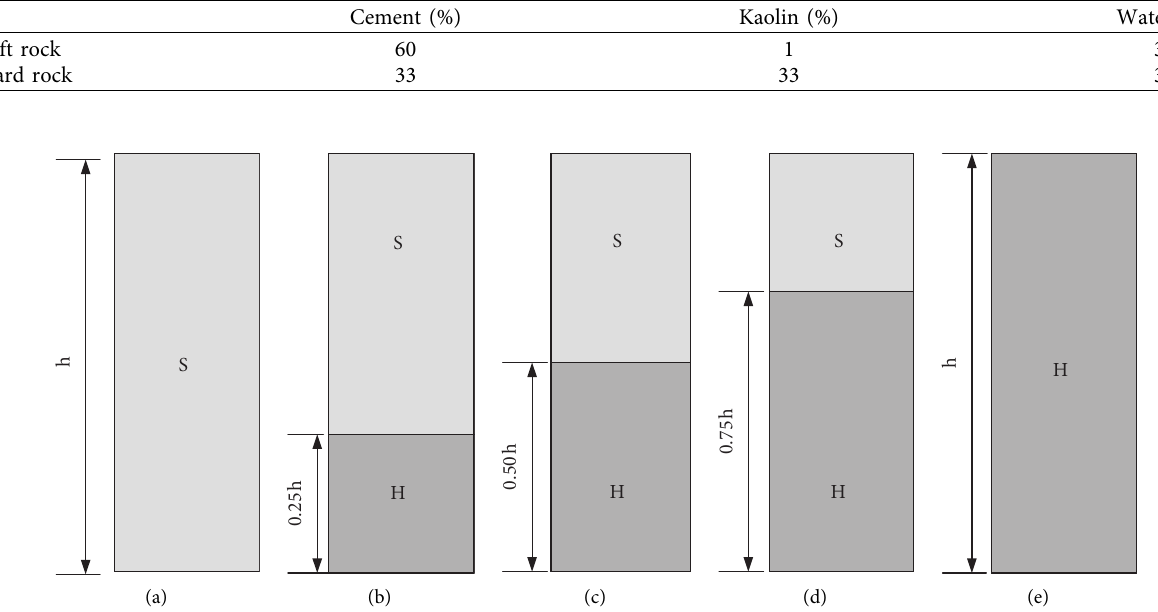
Table 1: Composition of the soft rock and hard rock.